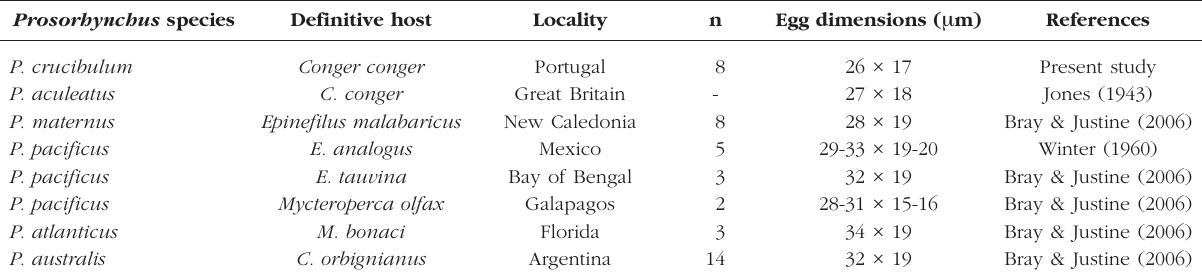
Table I. – Measurements of Prosorhynchus spp.